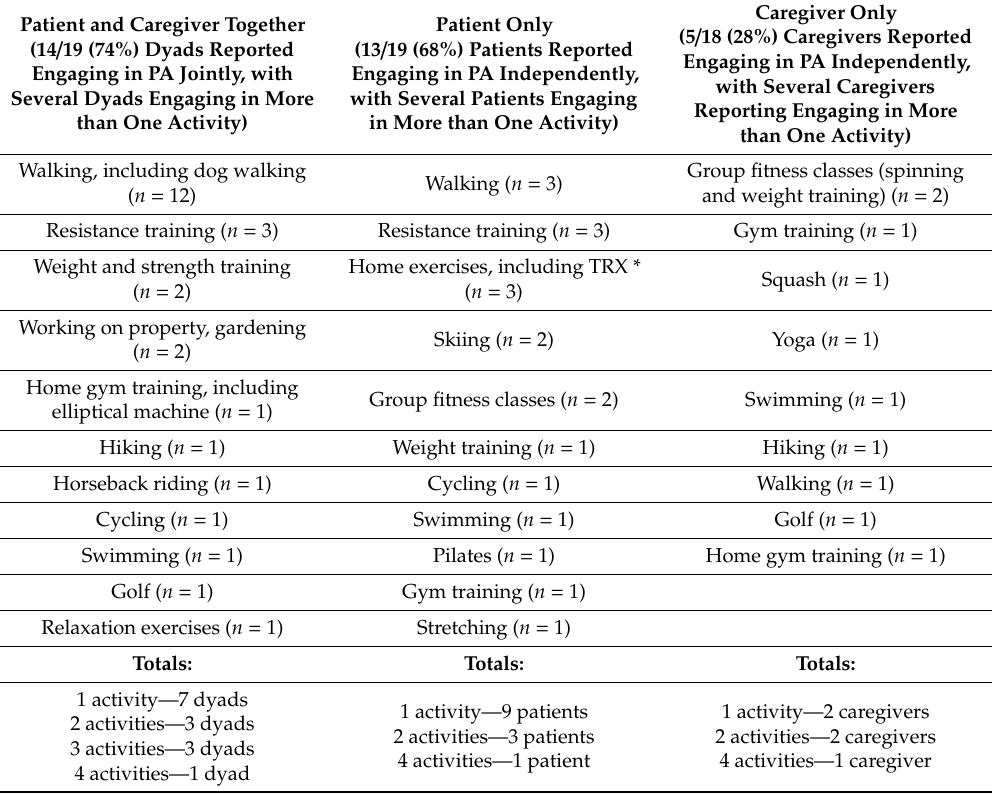
Table 2. Physical activity (PA) undertaken by dyads, patients, and caregivers during TEMPO. Caregiver Only Patient Only Patient and Caregiver Together (5 / 18 (28%) Caregivers Reported (13 / 19 (68%) Patients Reported (14 / 19 (74%) Dyads Reported Engaging in PA Independently, Engaging in PA Independently, Engaging in PA Jointly, with with Several Caregivers with Several Patients Engaging Several Dyads Engaging in More Reporting Engaging in More in More than One Activity) than One Activity) than One Activity) Group fitness classes (spinning Walking ( n = 3) and weight training) ( n =